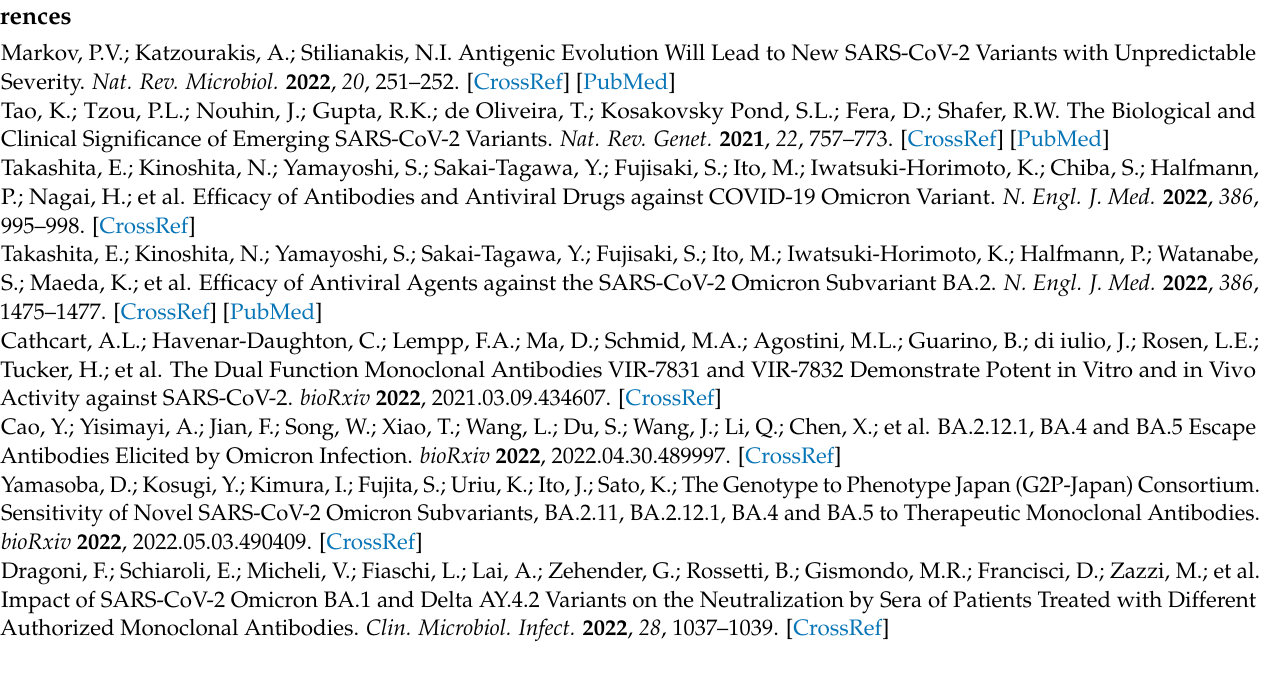
number and spike identified mutations. Table S2: Clinical features of enrolled individuals. Figure